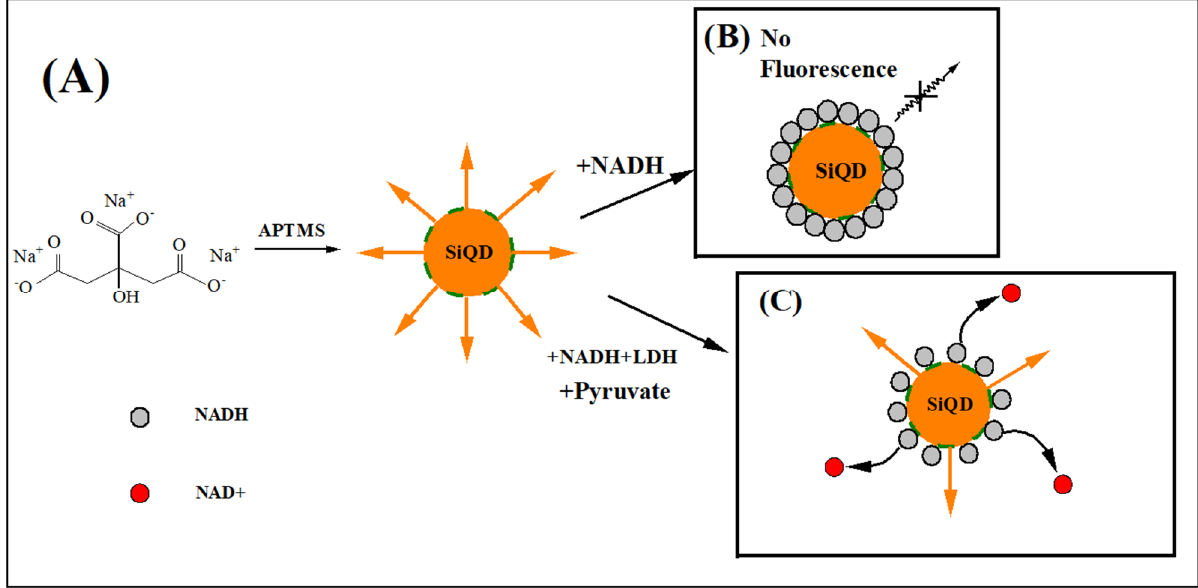
Figure 7. ( A ) The synthesis principle of SiQDs. ( B ) NADH quenches fluorescence of SiQDs. ( C ) Principle of LDH activity detection [12]. Copyright 2022 Elsevier.